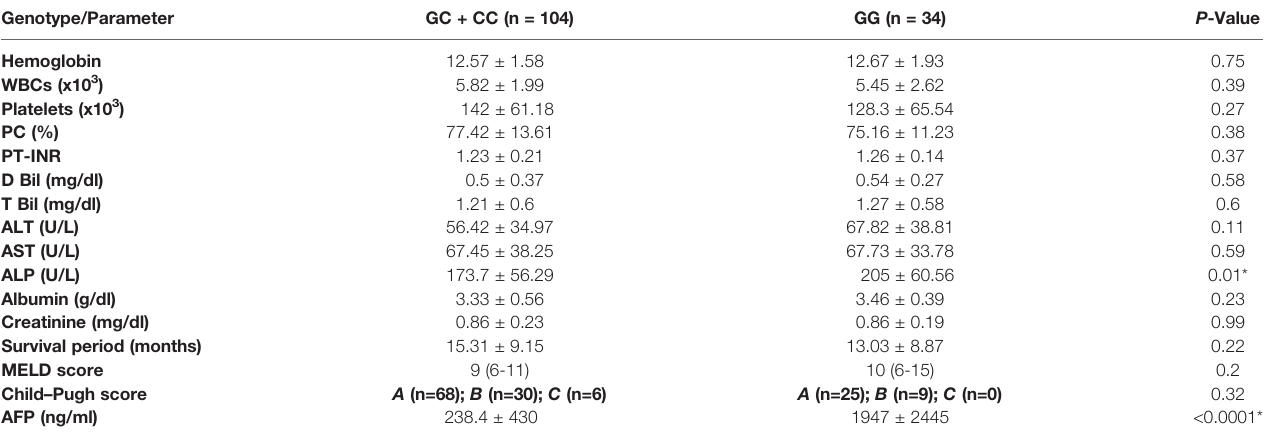
TABLE 5 | The associations of the biochemical parameters and the EpCAM -935 C/G polymorphism in HCC patients. Genotype/Parameter